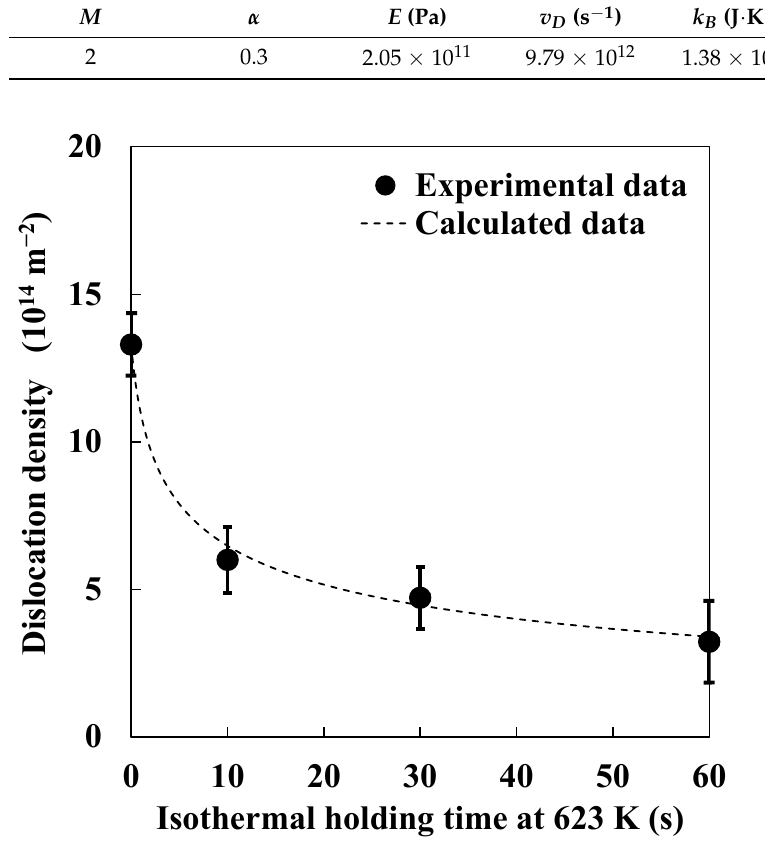
Figure 7. Changes in total dislocation density during isothermal holding at 623 K estimated by X-ray diffraction line profile analysis and the new model.